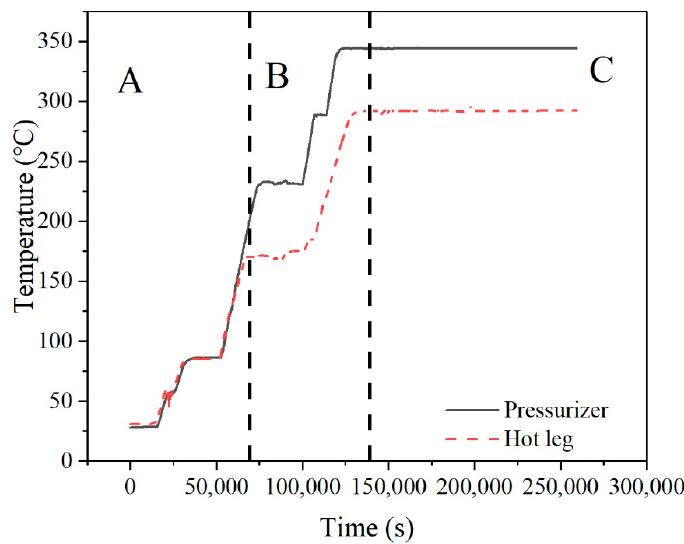
Figure 19. The temperature of the fluid in the pressurizer and hot leg.